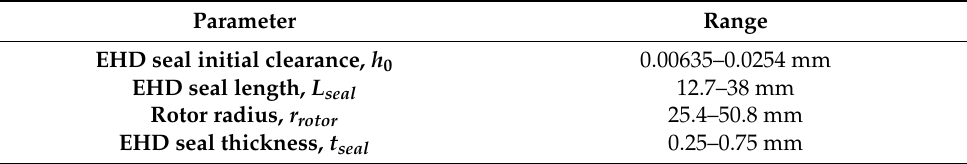
Table 2. Parameters with their respective